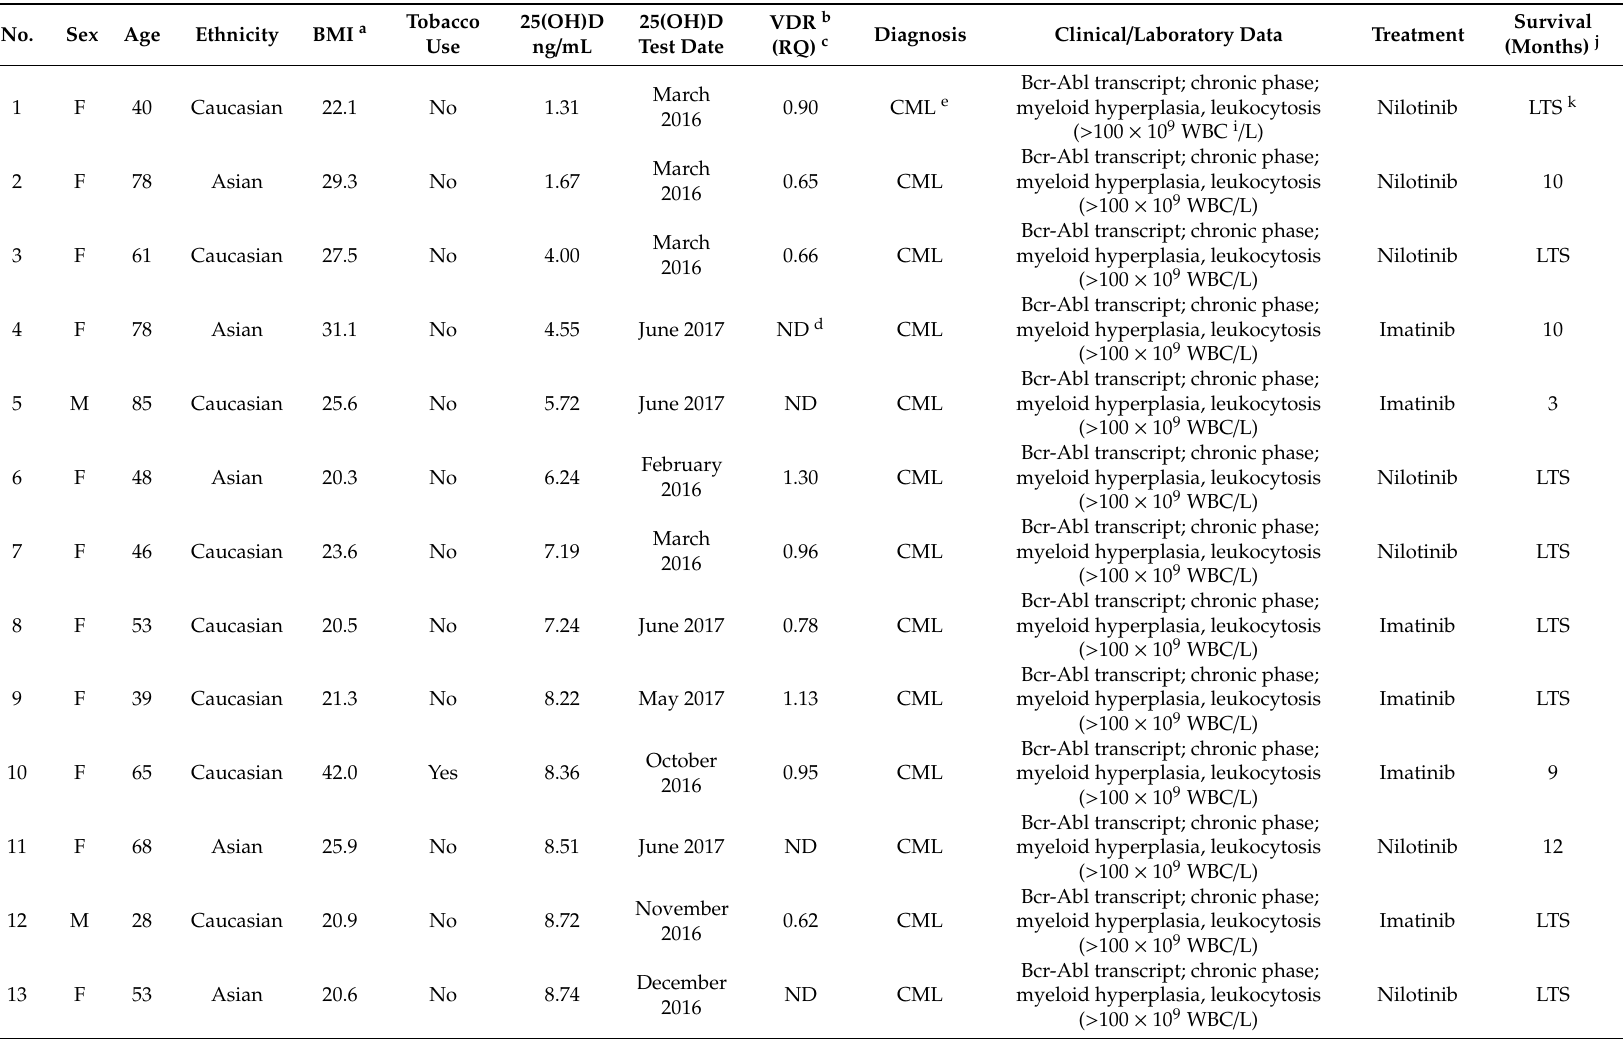
Table 1. Characteristics of participating patients ( n =